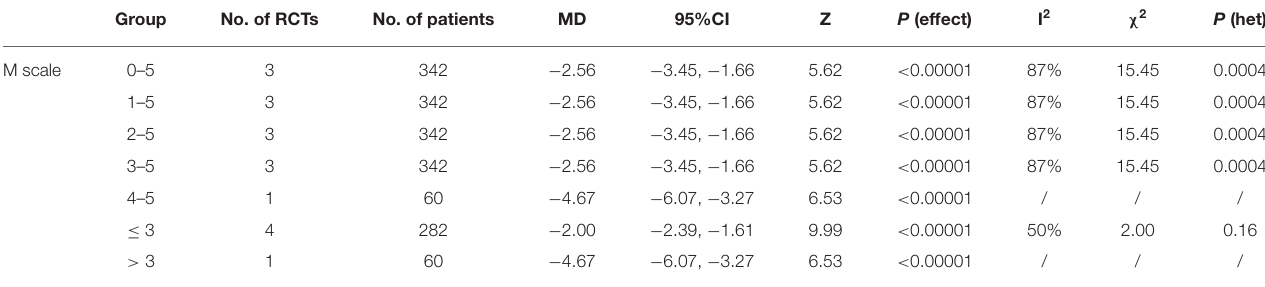
TABLE 6 | Sensitivity analysis based on the duration of angina attacks.